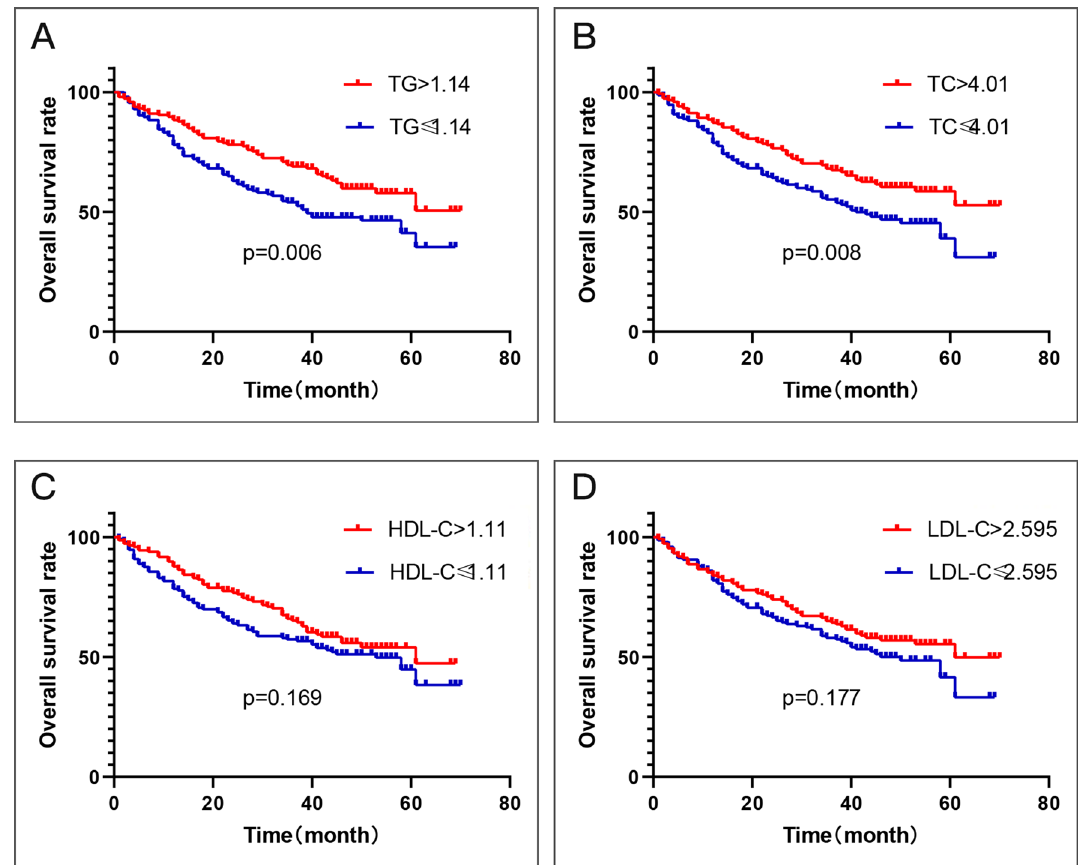
Figure 2. Kaplan–Meier curve for overall survival regarding normal vs disorder TG levels (P = 0.011) ( A ); normal vs disorder TC levels (P = 0.037) ( B ); normal vs disorder HDL-C levels (P = 0.223) ( C ); low vs high LDL-C levels (P = 0.104) ( D